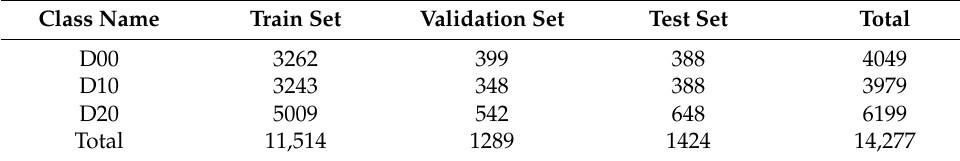
Figure 5. Sample images for pavement cracks and schematic diagram of each class. Table 1. The instance distribution of each class in the pavement crack dataset.